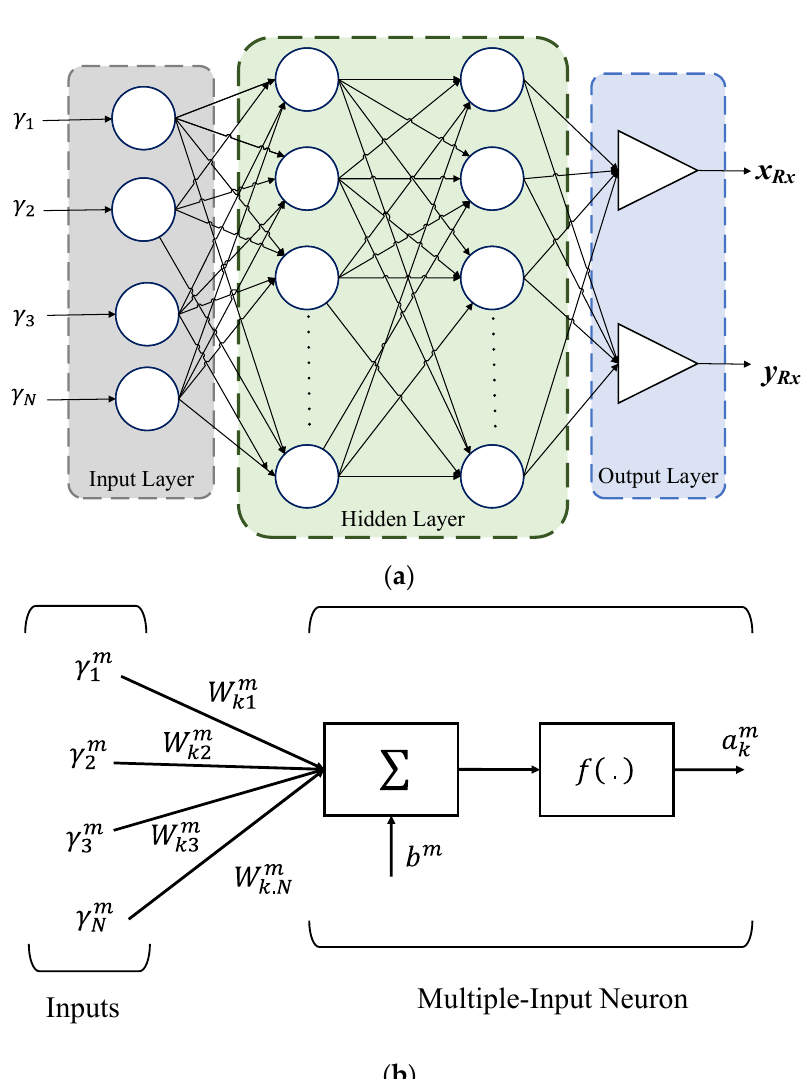
Figure 4. The artificial neural network with: ( a ) a basic structure; and ( b ) a structure of k th neuron with N inputs in the layer m .